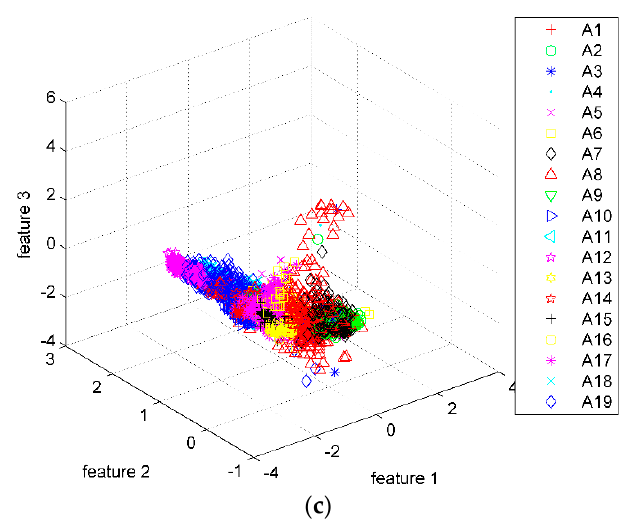
Figure 7. Scatter plots of PCA. There are totally 173,280 (= 9120 × 19) points in these scatter plots. According to the 19 activities, each point has been labeled with different legends. ( a ) Scatter plots of features 1 and 2; ( b ) Scatter plots of features 2 and 3; ( c ) 3-D scatter plots of features 1–3.